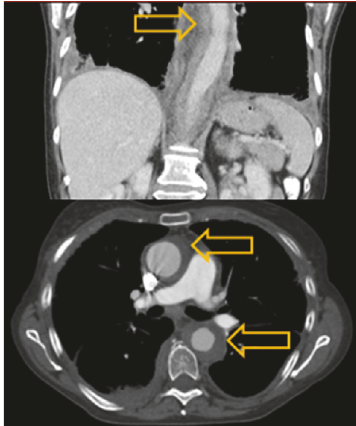
Figure 1: PET scan showing nodular FDG uptake in the wall of the thoracic and upper abdominal aorta and in the right atrium, suspicious for large cell arteritis.